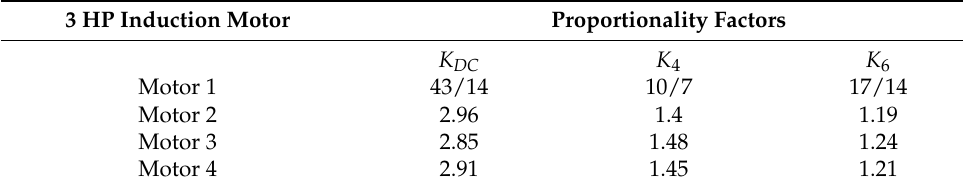
Table 5. K parameters